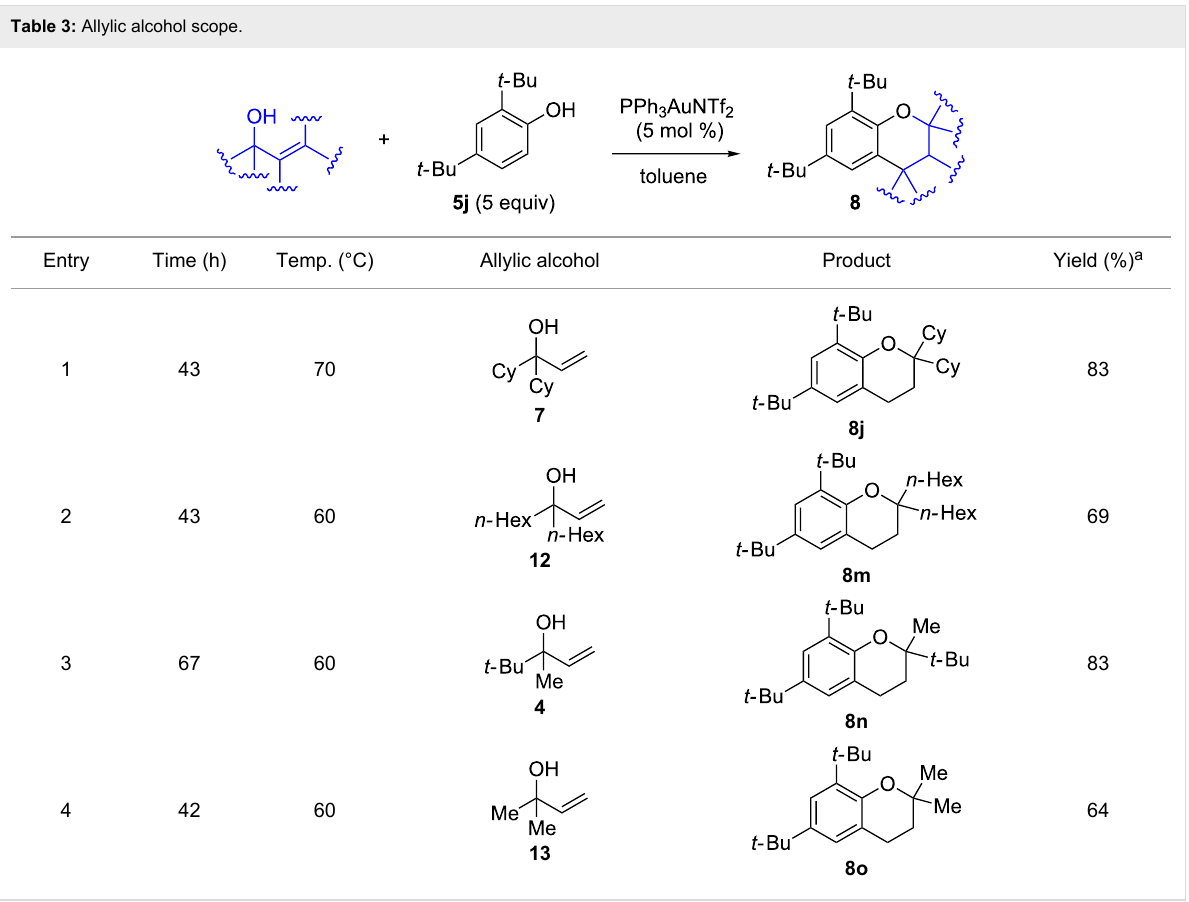
Table 3: Allylic alcohol scope.